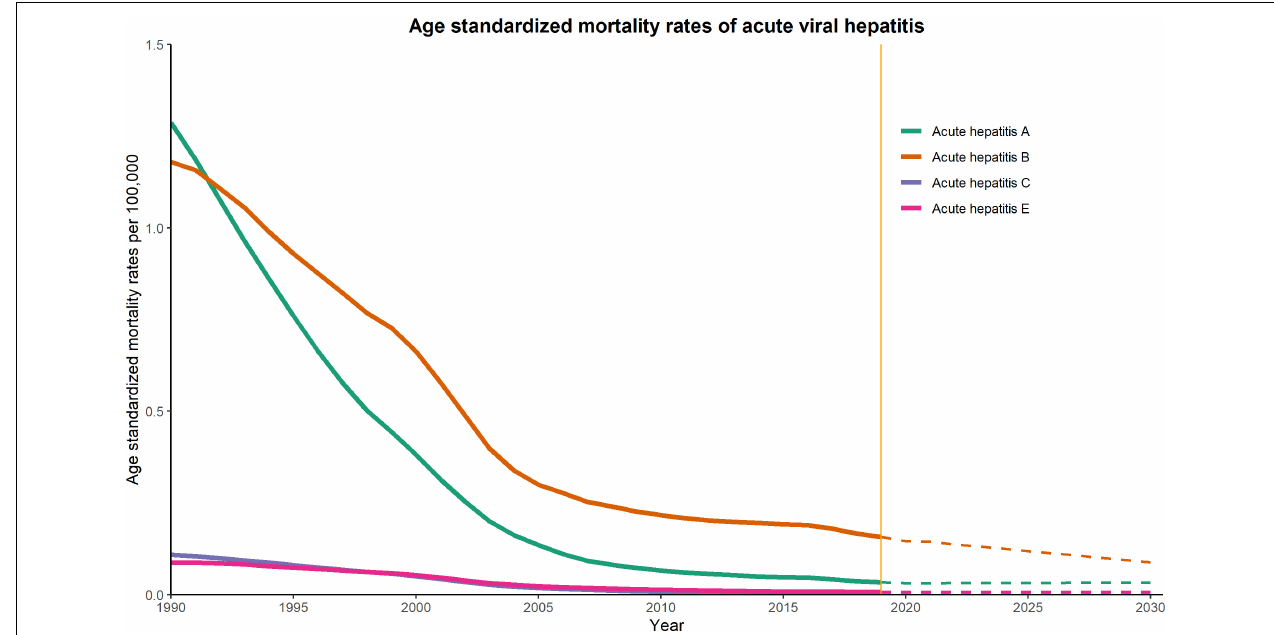
FIGURE 3 | Trends in observed (solid lines) and predicted (dashed lines) age-standardized mortality rate (ASMR) of acute viral hepatitis from 1990 to 2030 in